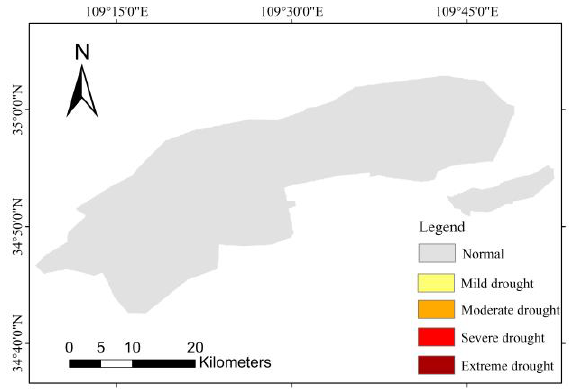
Figure 6. Drought monitoring results based on the anomaly vegetation index in the study in March 2016 in Donglei